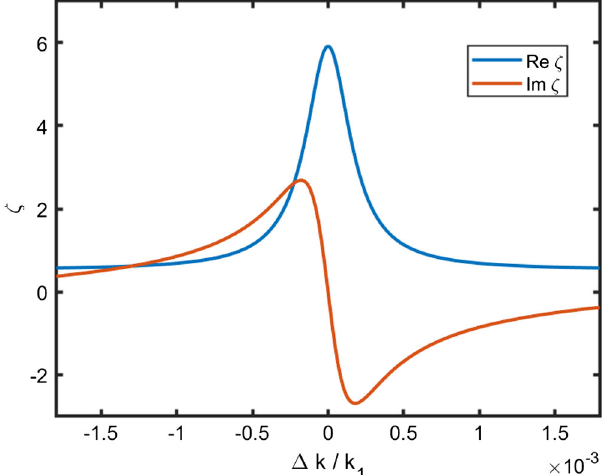
FIG. 2. ζ ¼ η exp ð − i ψ Þ as a function of the detuning parameter Δ k=k 1 . The half-width of the peak in the real part is roughly 3 = ð 2 Q Þ ¼ 0 . 4 × 10 − 4